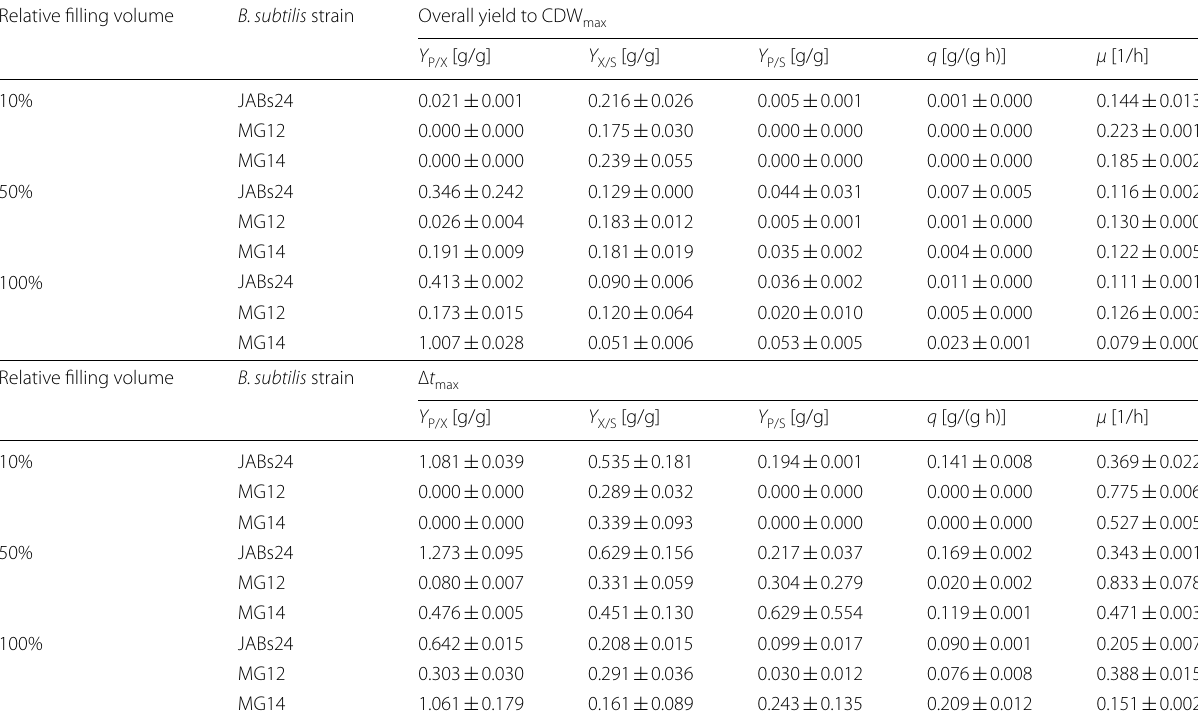
yields and specific growth rates µ of shake flask cultivations with max